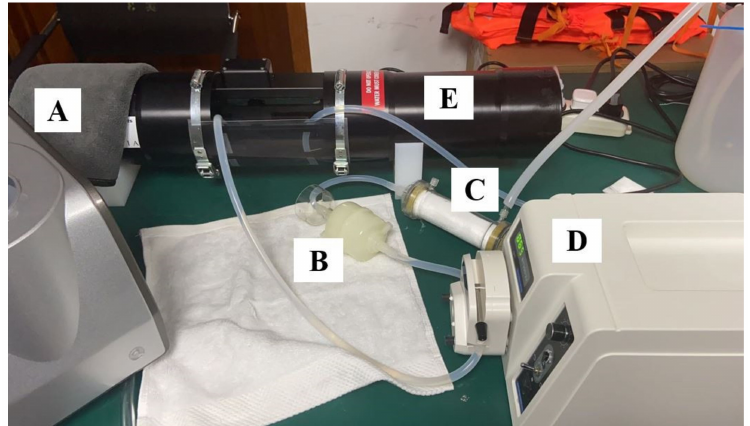
Figure 3. Installation of LISST-VSF in lab. (A) represents the opaque rag. (B) represents the poly- carbonate cartridge filter of pore size 0.2 µ m. (C) represents the Liqui-Cel Membrane Contactor. (D) represents the diaphragm pump. (E) represents LISST-VSF. The polycarbonate cartridge filter of pore size 0.2 µ m, the diaphragm pump, and the Liqui-Cel Membrane Contactor were connected through silica gel tube to form a filtration, degassing, and circulating